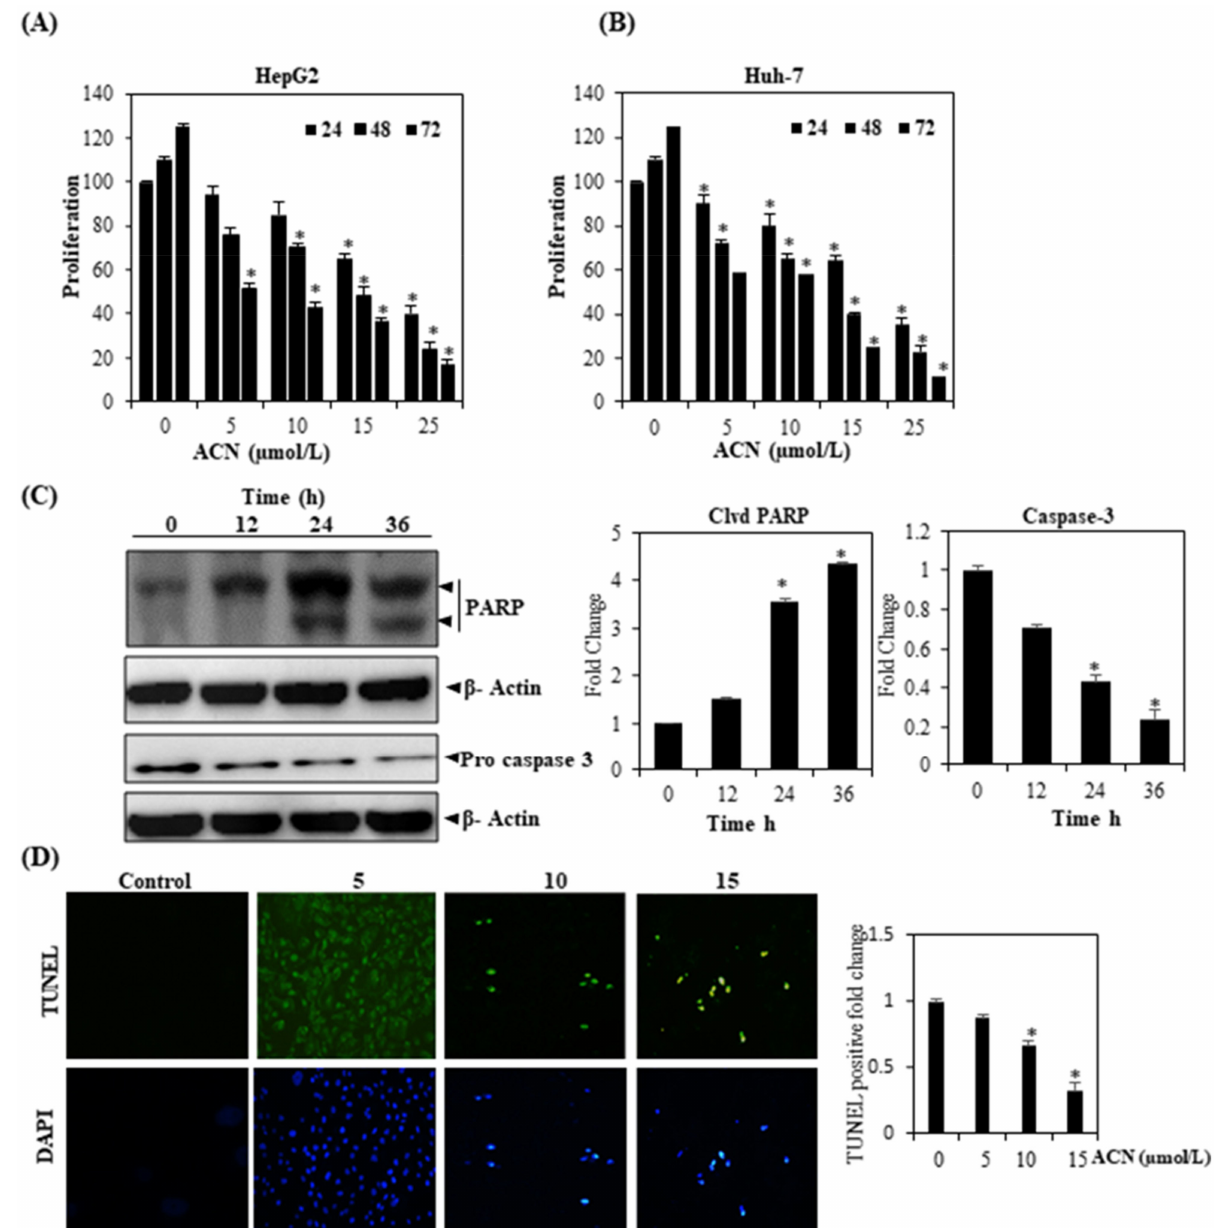
Figure 5. ACN suppresses proliferation, activating caspase-3. After Huh-7 and HepG2 were intro- duced in triplicate, they were exposed to ACN in predetermined concentrations. An MTT assay was then performed after 1, 2, and 3 days for examining cellular proliferation in ( A ) HepG2 and ( B ) Huh-7 cells. ( C ) After HepG2 cells were treated with ACN (15 µ mol/mL) for predetermined amounts of time, cell extracts were prepared and extracted on SDS-PAGE gel prior to undergoing Western blotting using antibodies against procaspase-3 and PARP. β -Actin antibody was used and re-investigate these blots following stripping to confirm equal protein loading. ( D ) DNA fragmentation was assessed using transferase-mediated dUTP-fluorescein nick end labeling (TUNEL). A microscope was used to observe three fields of cells containing average numbers related to apoptotic positive cells. The findings signify three experiments carried out independently (* p <